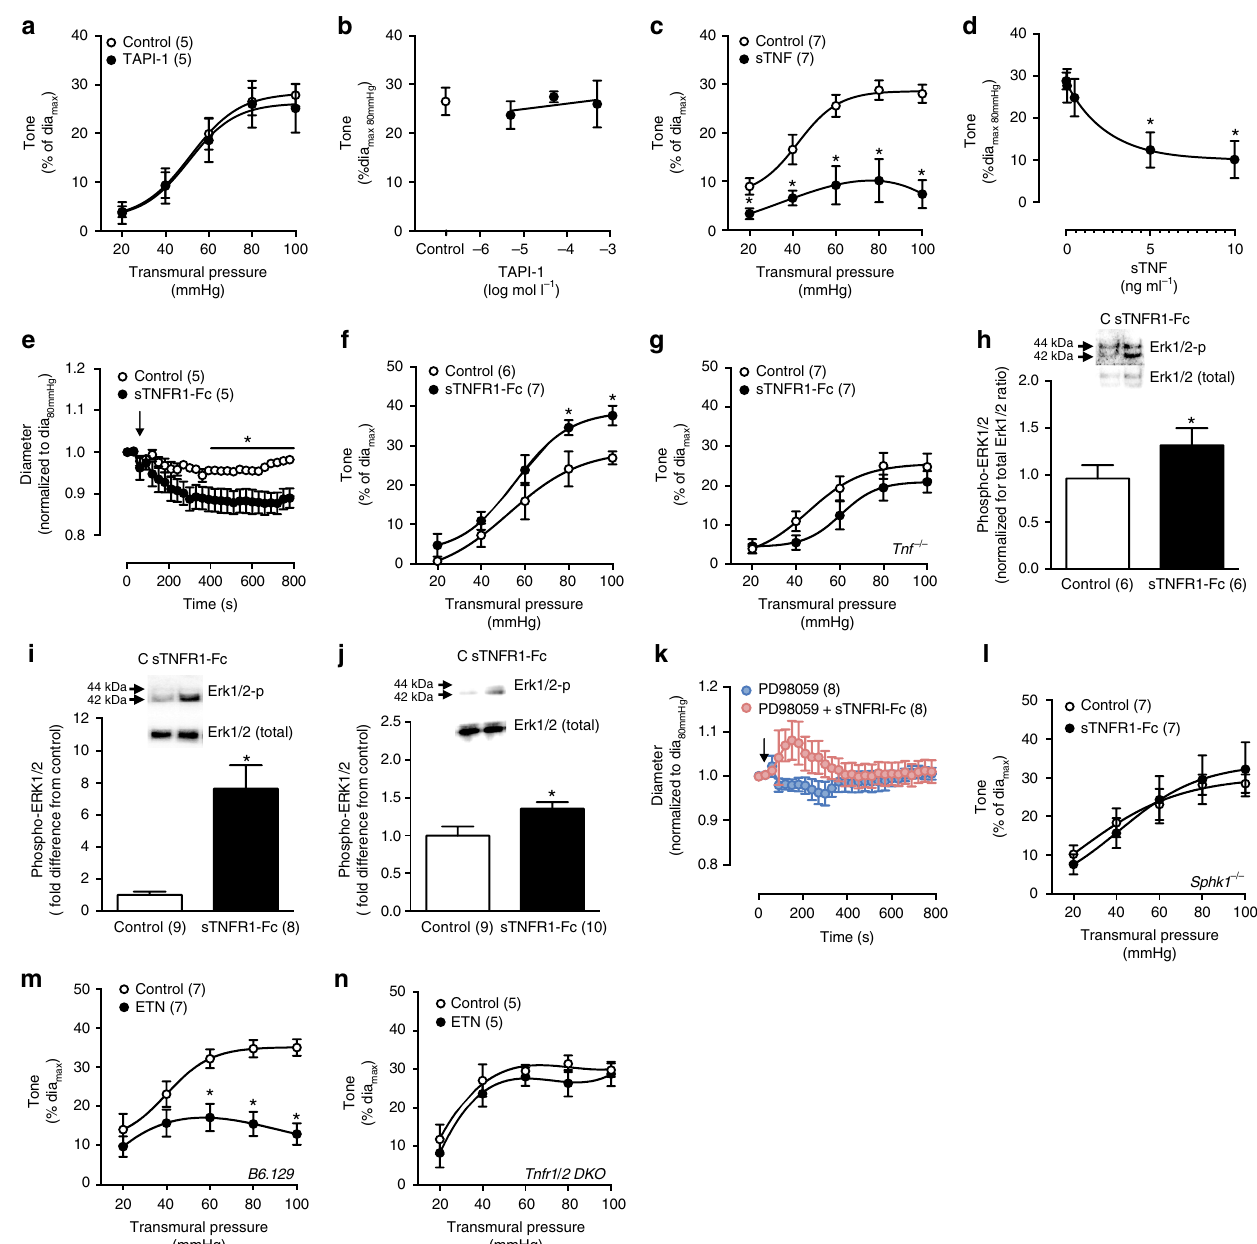
Figure 7 | TNF reverse signalling in the myogenic response. ( a ) Myogenic responses in the presence of the TNF converting enzyme inhibitor TAPI-1 (500 m moll (cid:2) 1 in vitro ) and ( b ) dose-dependency assessment at 80mmHg (control: n ¼ 5 arteries; 5 at (cid:2) 5.3, 4 at (cid:2) 4.3, 5 at (cid:2) 3.3logmoll (cid:2) 1 TAPI-1). ( c ) Myogenic responses in the presence of recombinant soluble TNF (sTNF, 10ngml (cid:2) 1 in vitro ) and ( d ) dose-dependency assessment at 80mmHg ( n ¼ 7 arteries at 0, 5 at 0.05, 7 at 0.5, 6 at 5 and 6 at 10ngml (cid:2) 1 sTNF). ( e ) Wild-type cremaster artery diameter measurements at 80mmHg transmural pressure following application of an intrinsically active soluble TNFR1 fragment (sTNFR1-Fc; 100ngml (cid:2) 1 , arrow); data are normalized to baseline diameter (10s average control: 51 ± 5, sTNFR1-Fc: 51 ± 5). ( f , g ) Myogenic responses conducted in the presence of sTNFR1-Fc in vitro (100ngml (cid:2) 1 ) in ( f ) wild-type and ( g ) Tnf (cid:2) / (cid:2) cremaster arteries. ( h – j ) Representative western blot assessments and statistical analysis of ERK1/2 phosphorylation under control condition (C) and following sTNFR1-Fc (100ngml (cid:2) 1 ) application to ( h ) cremaster arteries at 80mmHg transmural pressure, ( i ) cultured mouse mesenteric vascular smooth muscle cells, and ( j ) cultured human coronary artery smooth muscle cells. Uncropped western blot images are shown in Supplementary Fig. 10. ( k ) Wild-type cremaster artery diameter measurements at 80mmHg transmural pressure following application of sTNFR1-Fc (100ngml (cid:2) 1 , arrow) in the presence of 10 m moll (cid:2) 1 PD98059; data are normalized to baseline diameter (10s average control: 51 ± 4, sTNFR1-Fc: 51 ±